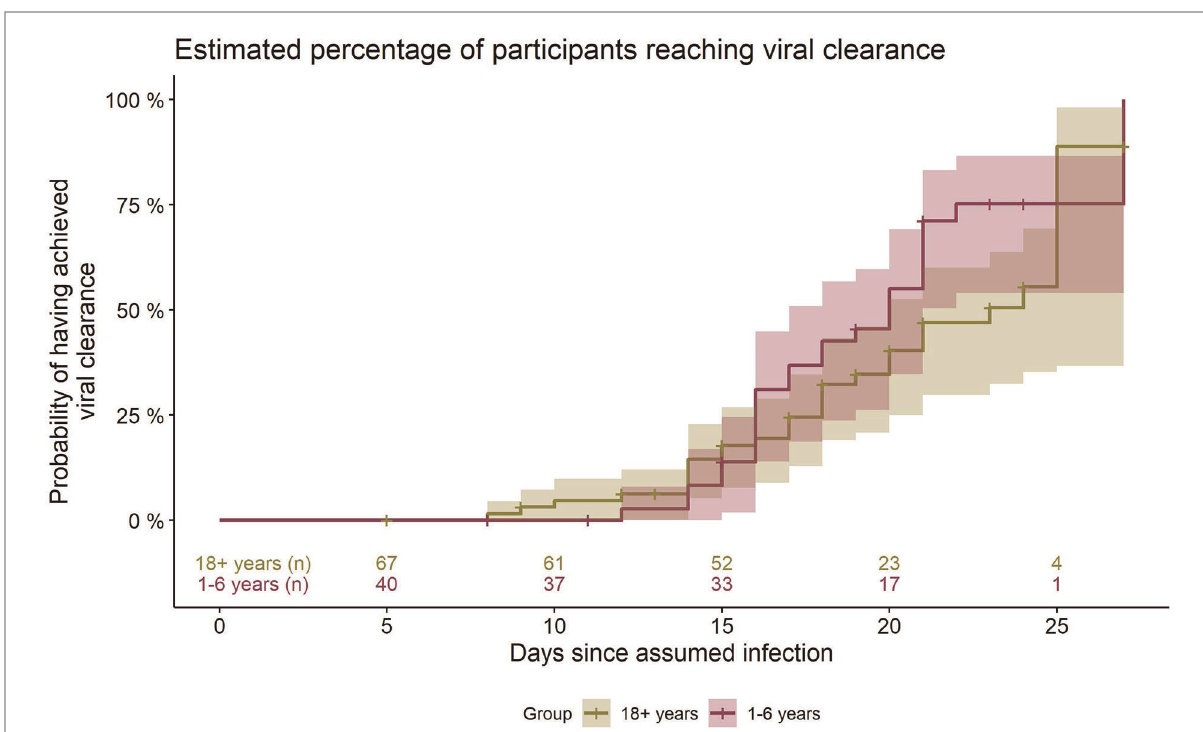
FIGURE 3 Estimated percentage (from Kaplan-Meier survival analysis) of daycare children and adults having accomplished viral clearance at the respective timepoints during the course of infection. Days counted since day of assumed infection (day zero). Group 18+ and 1 – 6 years: numbers of participants still positive immediately before the respective time point. Shaded area: 95%